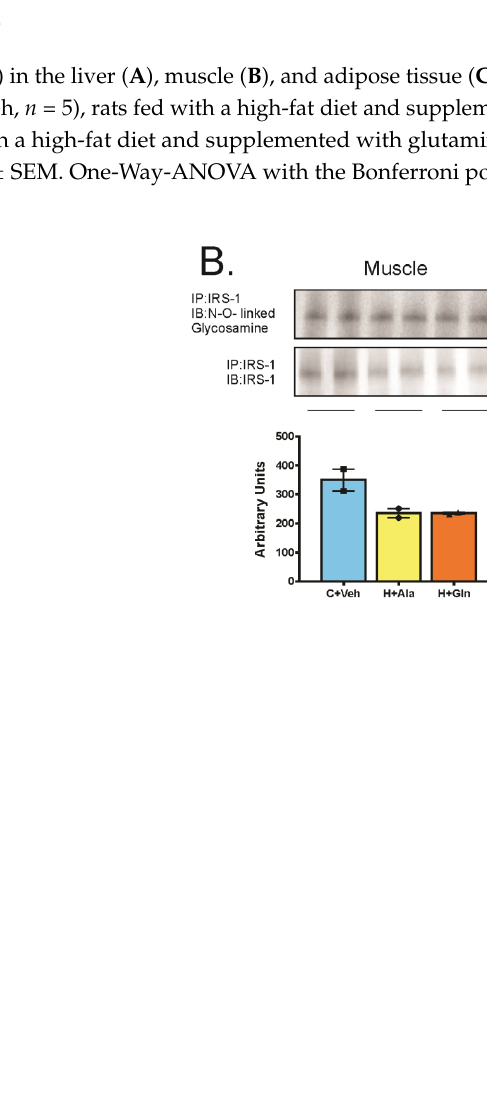
Figure 6. Insulin receptor substrate 1 (IRS1) association with N- O -linked glycosamine in the liver ( A ), muscle ( B ), and adipose tissue ( C ). Rats that received a chow diet and vehicle (C+Veh; n = 2), rats fed with high-fat diet and supplemented with Alanina (H+Ala; n = 2), and rats fed with a high-fat diet and supplemented with glutamine (H+Gln; n = 2). Values were displayed as mean ± SEM. One-Way- ANOVA with the Bonferroni post-test was used. * p < 0.05 vs C+Veh and H+Ala.